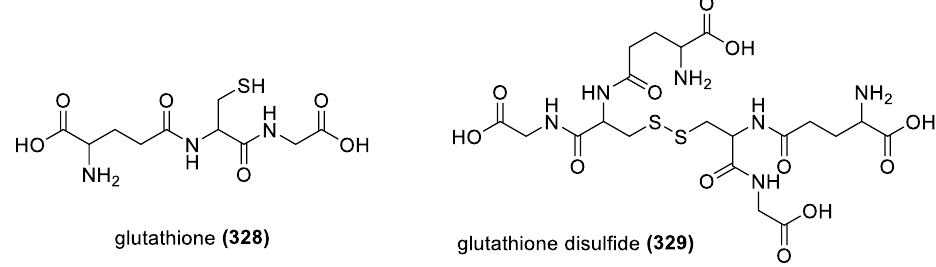
Figure 21. Structure of glutathione in its monomer sulfhydryl and disulfide forms.